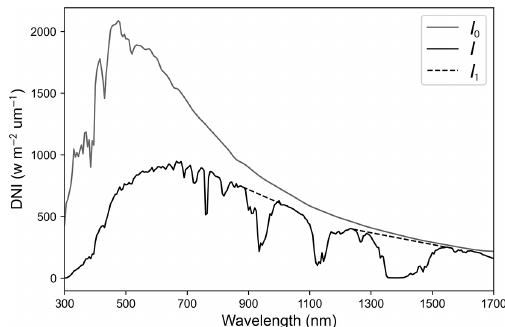
Figure 4. Direct normal solar irradiance reaching the surface ( I) , the solar irradiance at the top of the atmosphere ( I 0 ) , and the irra- diance after approximately removing the water vapor absorption by interpolating the baseline points outside the water vapor band ( I 1 )